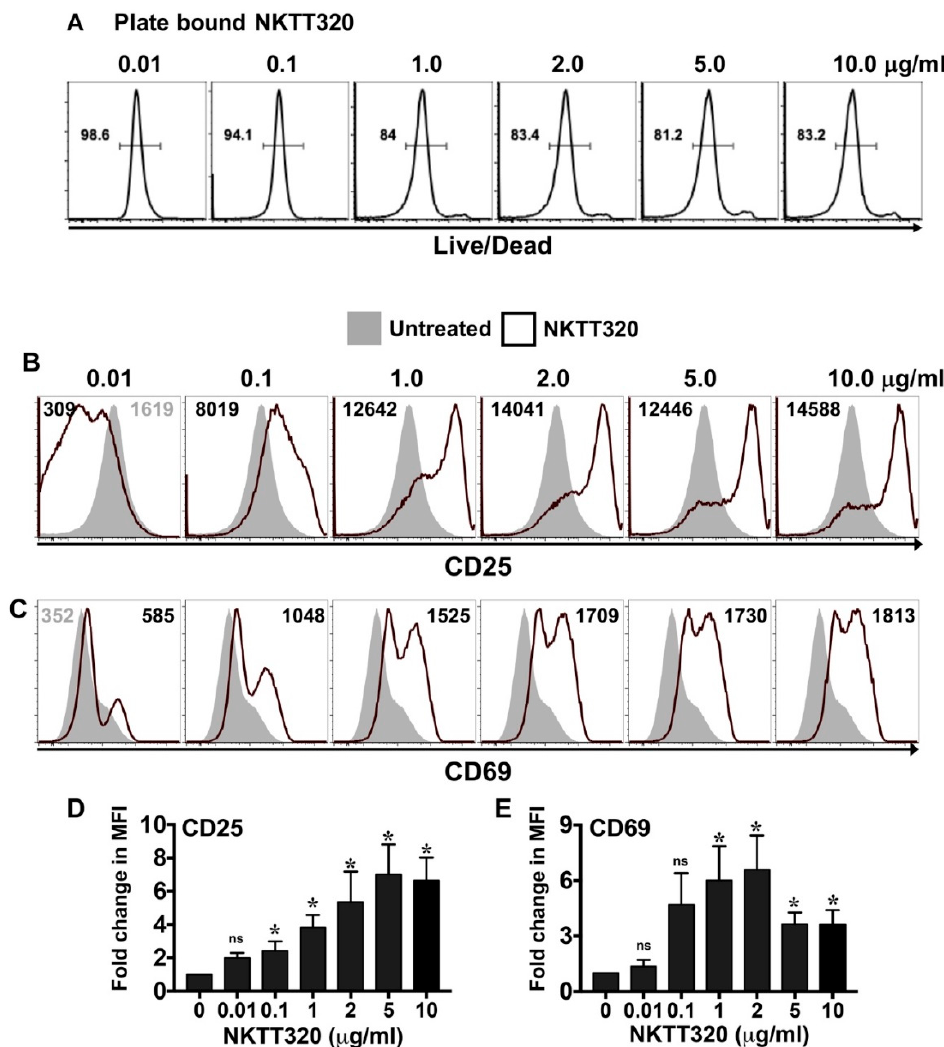
Figure 1. Dose-dependent activation of human invariant natural killer T cells (iNKTs) in the presence of immobilized NKTT320 in vitro. ( A – E ) Human iNKTs were incubated with no stimulus or increasing concentrations of plate-bound NKTT320 mAb. After 24 h, cells were stained with LIVE / DEAD Fixable Aqua Dead Cell dye and analyzed for viability ( A ) by flow cytometry. Representative histograms from one of six independent experiments are shown. Numbers in the histograms indicate percent viable cells. ( B – E ) Cells were also analyzed for expression of the activation markers CD25 ( B ) and CD69 ( C ) by flow cytometry. Representative histograms from one of five independent experiments are shown. Numbers in the histograms indicate the mean fluorescence intensity (MFI). Compiled data (mean ± SEM) from five independent experiments show fold increases in CD25 ( D ) and CD69 ( E ) expression on iNKTs plated on immobilized NKTT320, as compared to cells left untreated. Statistical significance in ( D , E ) was determined using an unpaired t -test with Welch’s correction. For each of the analysis, all the groups were compared to cells that were left unstimulated. * p < 0.05, ns: not significant.